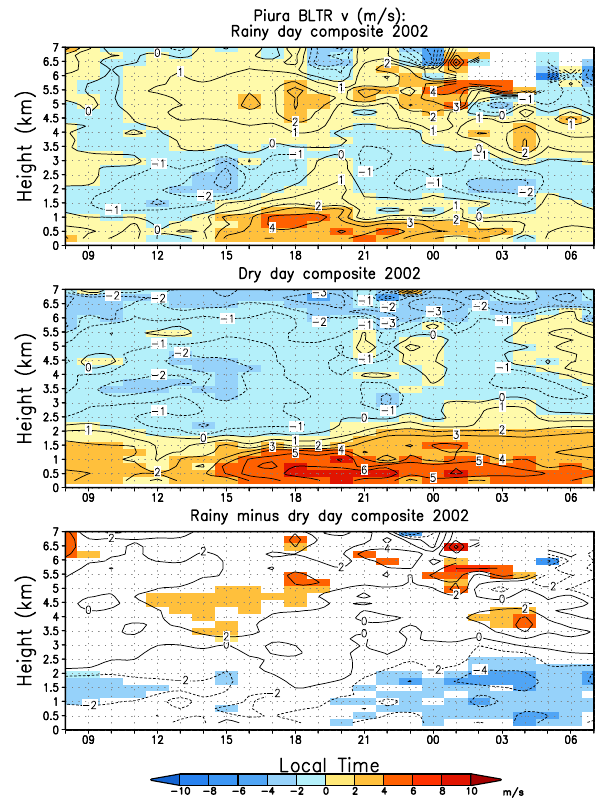
Fig. 9. Similar to Fig. 8 but for meridional